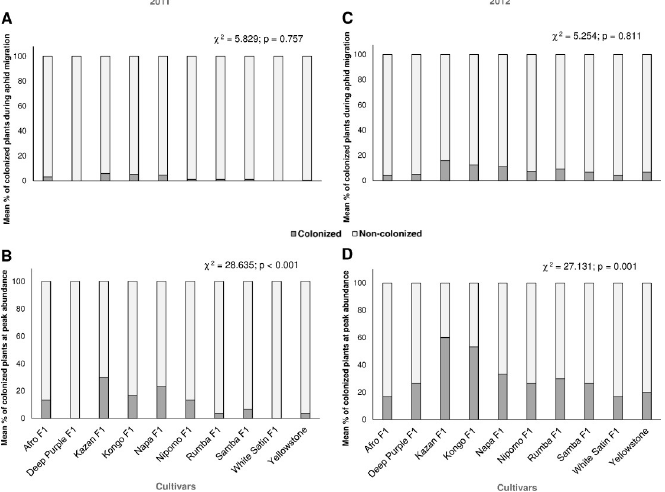
Fig 2. Colonization of carrot plants by Dysaphis crataegi : (A, C) during aphid migration and (B, D) at peak aphid abundance (Chi-square ( χ 2 ) test, df =